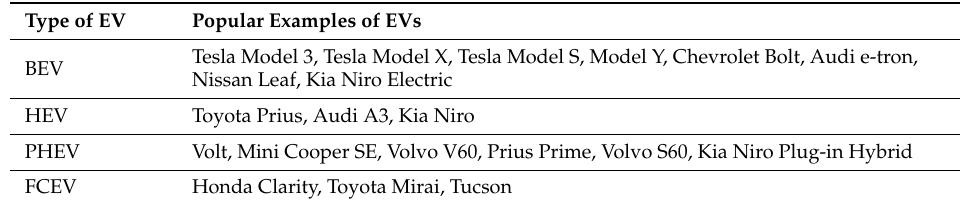
Figure 3. Proportion of various EV models available on the market. Table 1. Types of EVs and their popular examples.